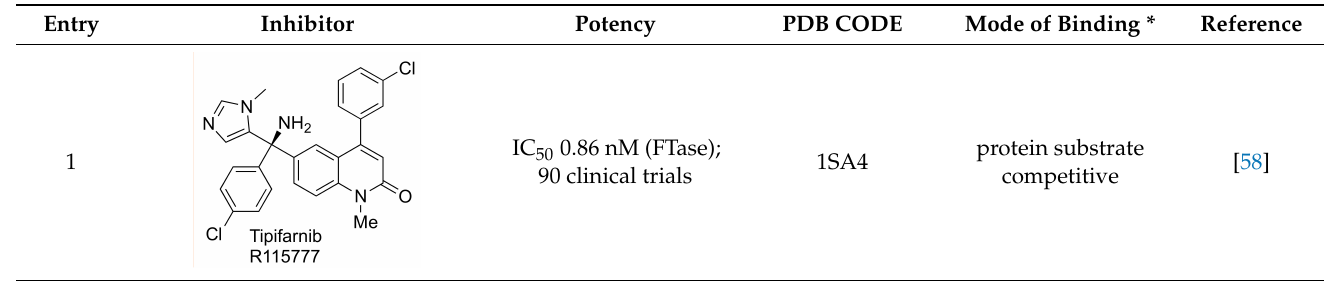
Table 2. Selected inhibitors of